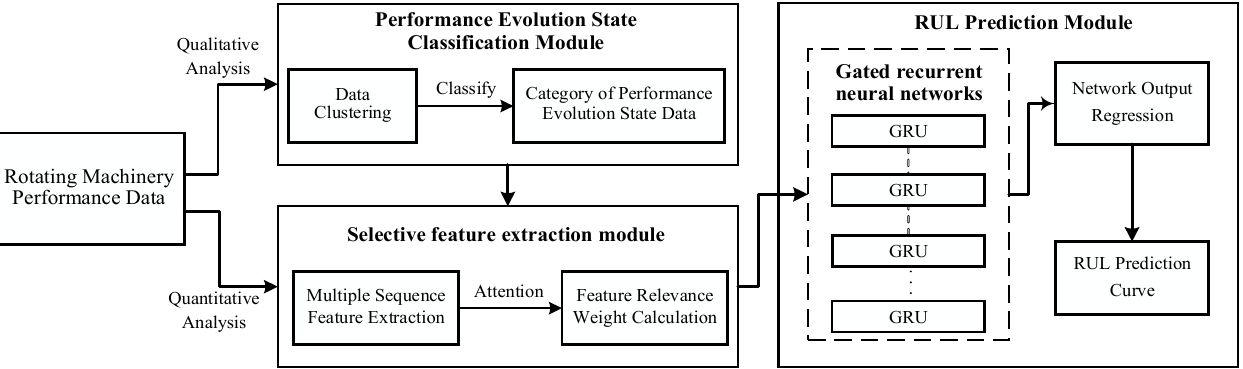
Figure 1. Architecture of an RUL prediction model for rotating parts.